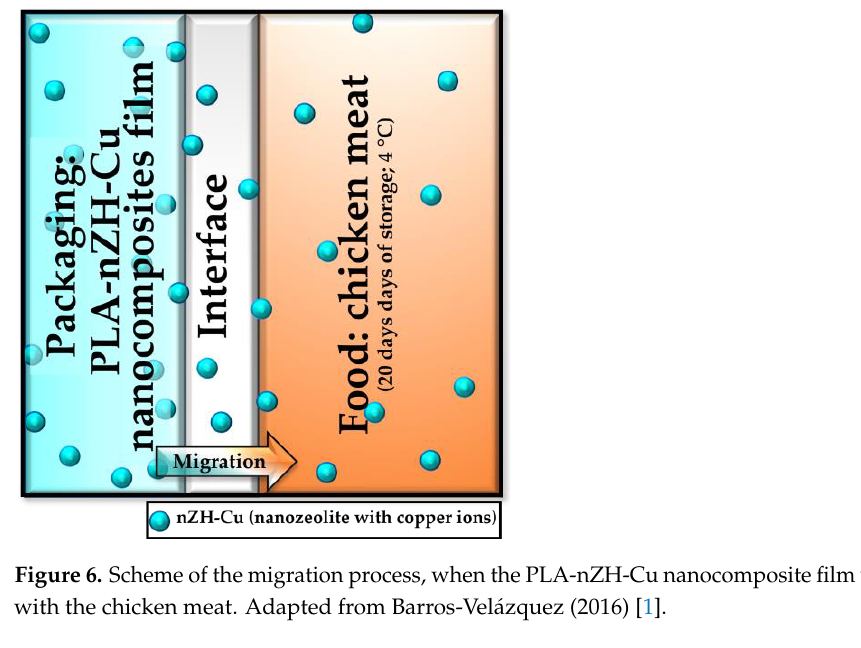
Table 3. Instrumental color quality (chroma, hue, and E) of chicken breast meat in contact with PLA-nZH-Cu nanocomposite films during storage at 4 ◦ C for 20 days.